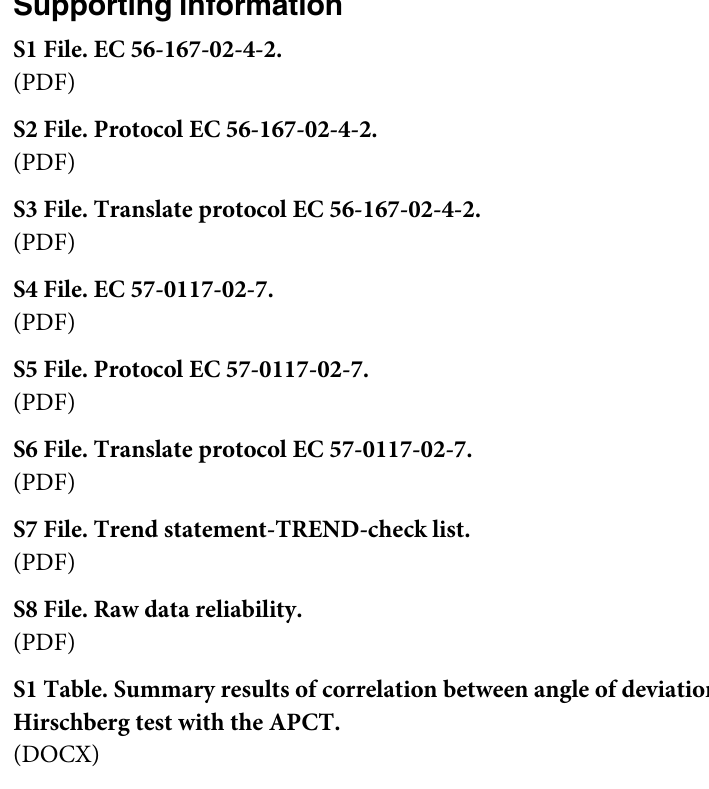
S1 Table. Summary results of correlation between angle of deviation from the Photo- Hirschberg test with the APCT. S2 Table. Summary results of correlation between angle of deviation from the Krimsky with the